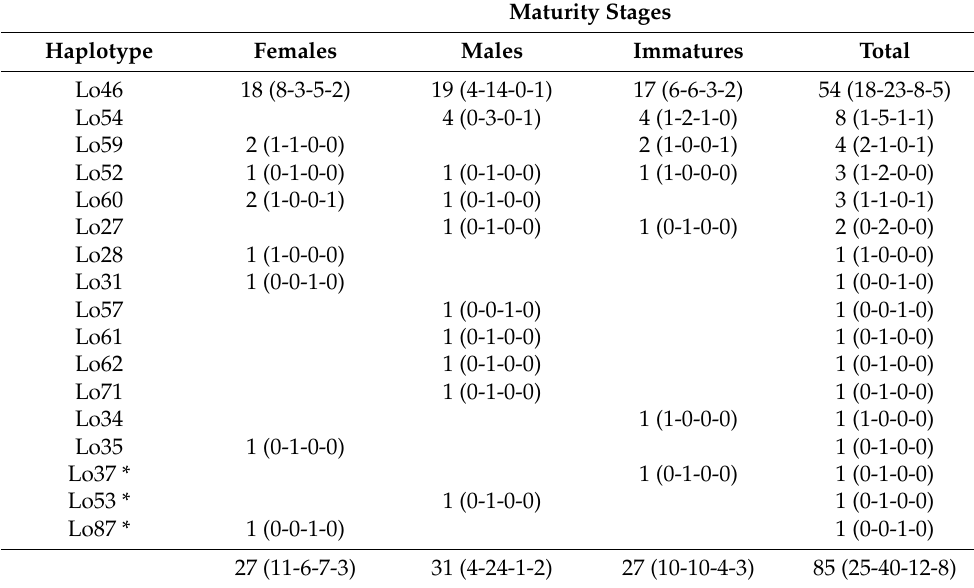
Table 1. mtDNA control region haplotype frequencies (751 pb) identified for olive ridleys sampled in the Central Mexican Pacific. In brackets, for each life stage, shows the number of individuals per sampling zone (northern continental-southern continental-northern oceanic-southern oceanic). * Indicates new